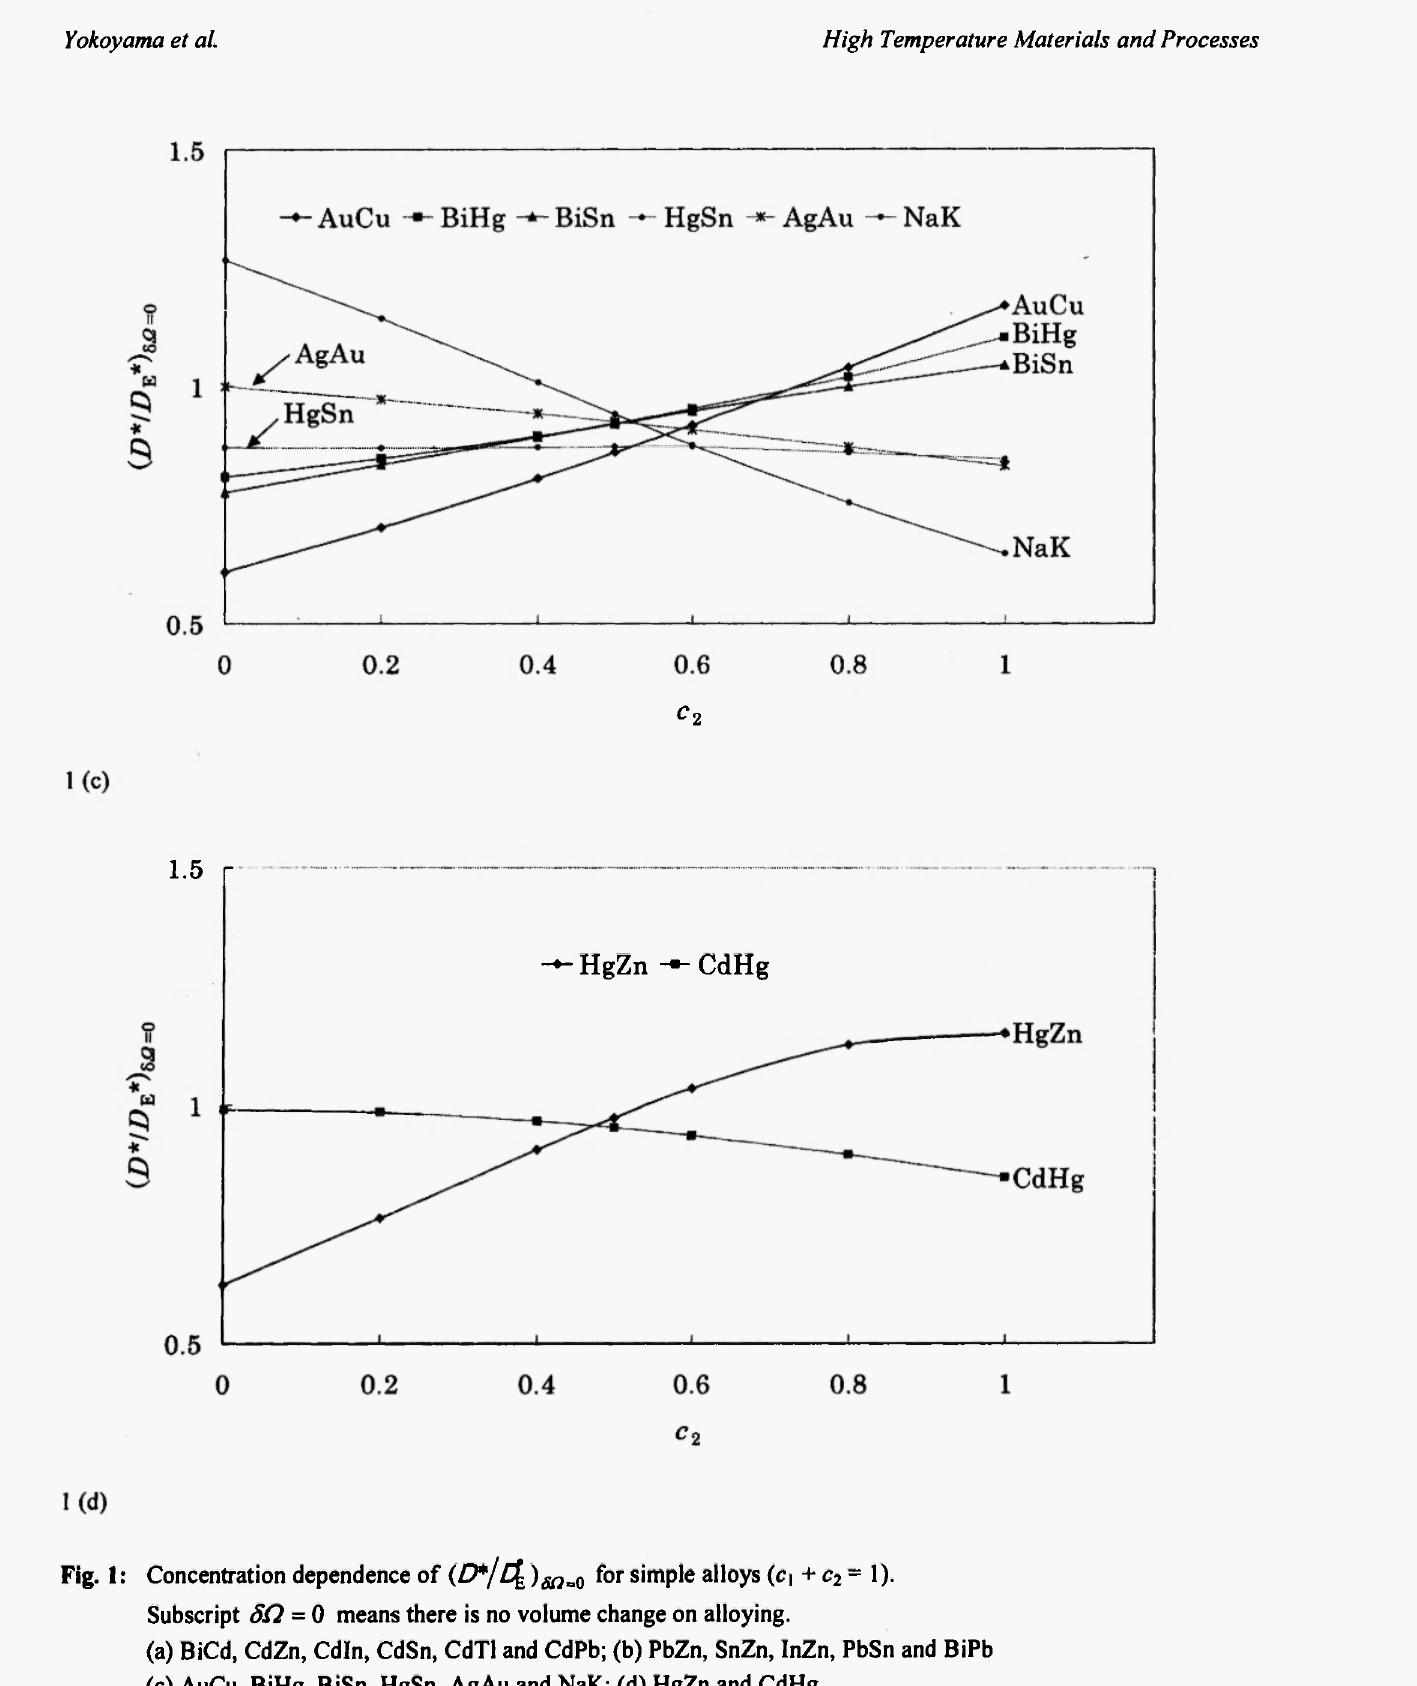
Fig. 1: Concentration dependence of (D*/Z^ ) <Sf?a0 for simple alloys (C| + c 2 = 1 ). Subscript δΩ = 0 means there is no volume change on alloying, (a) BiCd, CdZn, Cdln, CdSn, CdTl and CdPb; (b) PbZn, SnZn, InZn, PbSn and BiPb (c) AuCu, BiHg, BiSn, HgSn, AgAu and NaK; (d) HgZn and